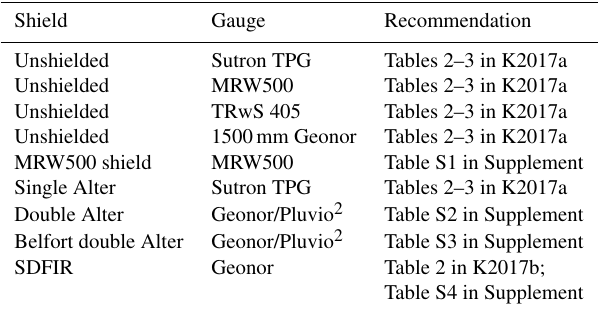
Table 3. Recommended transfer functions for different weighing precipitation gauges and